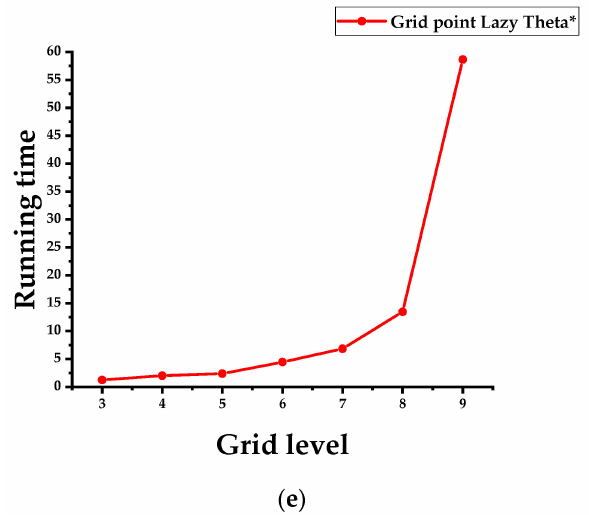
Figure 22. Lazy Theta* data change diagram of grid points at different grid levels. ( a ) Path length variation graph, ( b ) Path cost variation graph, ( c ) Maximum turning angle change diagram, ( d ) Maximum pitch angle change diagram, and ( e ) Running